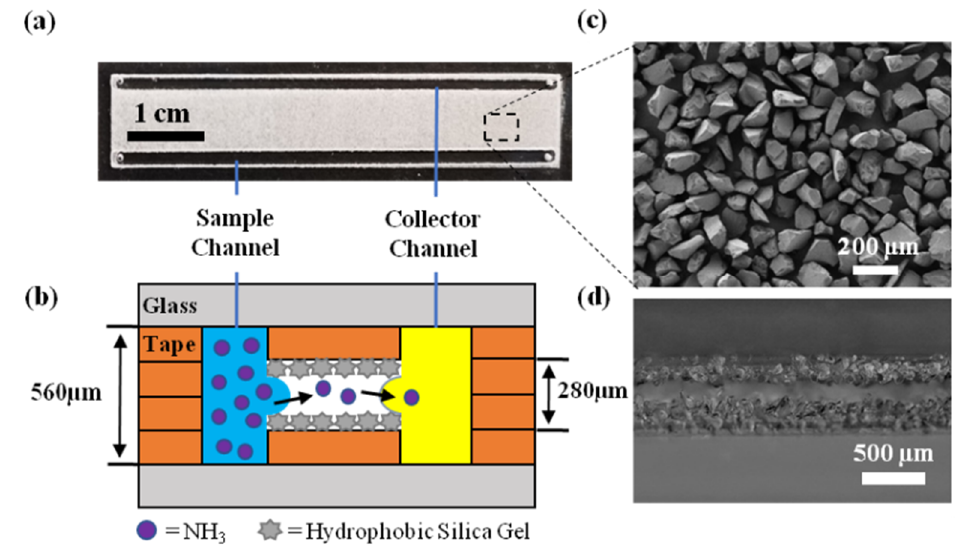
Figure 1. ( a ) Optical image of the microfluidic device with parallel sample and collector channels; ( b ) schematic representation of the mass transfer of analytes from sample stream to collector stream; ( c ) SEM image of the modified glass surface covered by hydrophobic silica gel glued by adhesive tape; and ( d ) microscopy image of the cross-section of the gap.